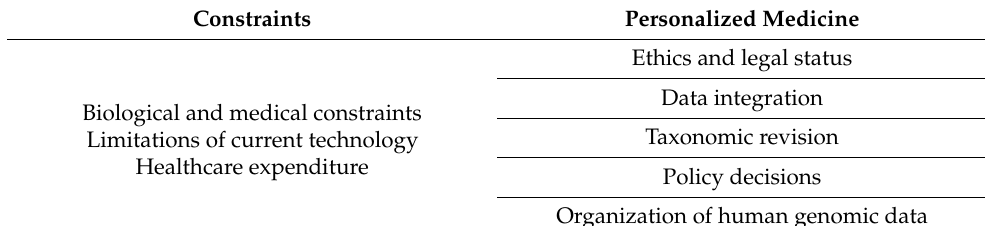
Table 1. Constraints and personalized medicine in cardiovascular